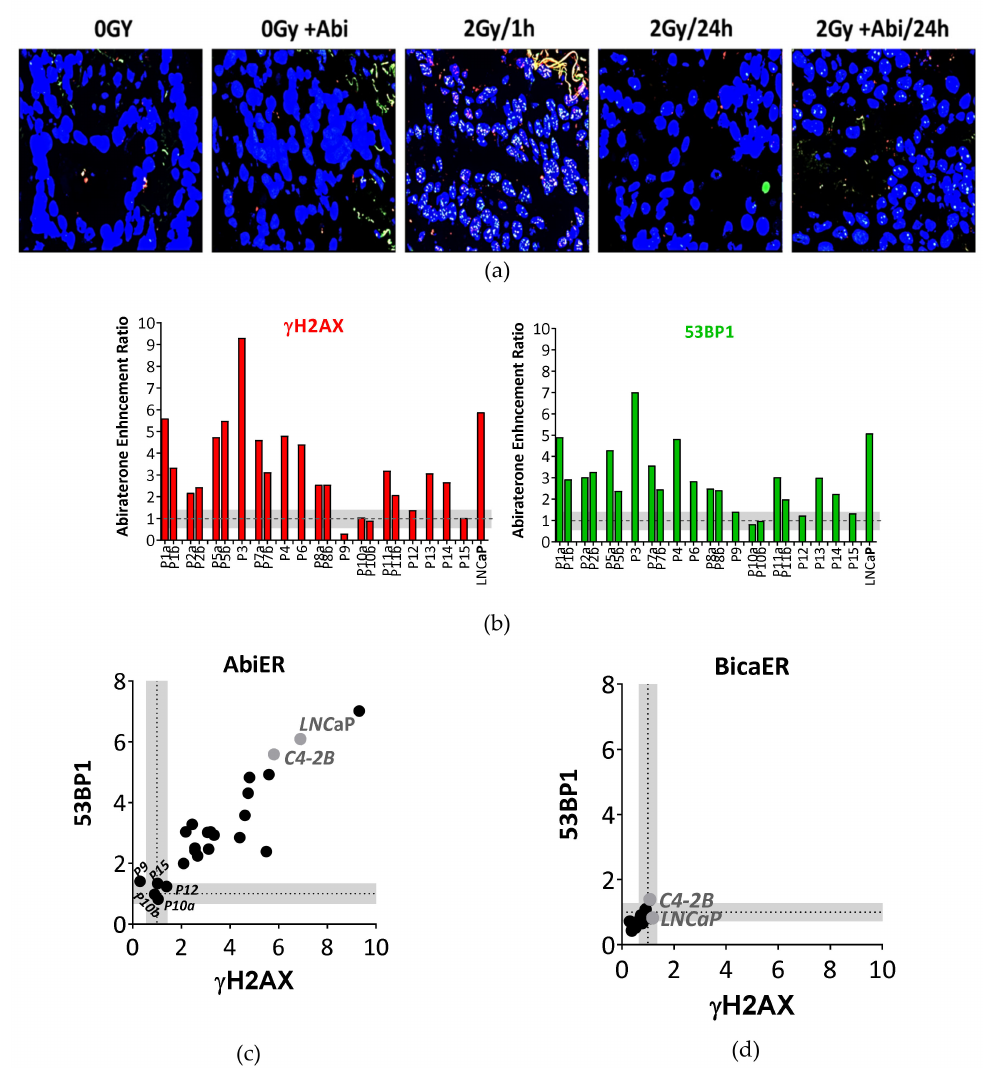
Figure 8. Abiraterone e ffi ciently suppresses DSB repair in fresh PCa tissues after ex vivo irradiation. ( a ) Representative immunofluorescence micrographs for γ H2AX (red) and 53BP1 (green) foci after the indicated treatments in freshly collected tumor tissue from PCa patient P5. ( b ) Abiraterone-mediated enhancement ratio (AbiER) on γ H2AX (left panel) and 53BP1 (right panel) foci of 22 punch biopsies from 15 PCa patients. ( c , d ) Correlation between (C) AbiER or (D) BicaER on γ H2AX and 53BBP1 foci. Threshold in grey was calculated as the mean standard error for each DSB marker in all